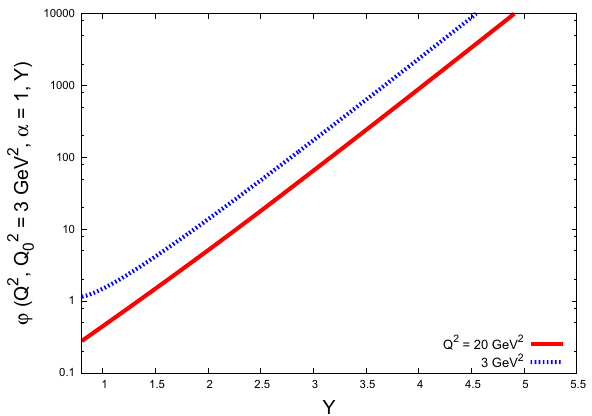
vector components with n = 3 , 20, and α = 1 (cid:4) φ vector in the truncated BFKL case, in the present work the expression in Eq. (23) for a matrix of size N = 50 with an = δ N 0 ) and a coupling initial condition N 0 = 3 (with ϕ 0 i i α = 1 has been calculated. Then, a look at the n = 3 , 20 components of the resulting (cid:4) φ and the study of its dependence with Y is provided in Fig. 6. It can be seen that the behaviour is very similar to that of the BFKL gluon Green’s function in Fig. 5 but with a smaller growth in the truncated case (note that in BFKL the asymptotic growth corresponds to the Pomeron intercept 4 log ( 2 ) ). It is possible to investigate how the asymptotic growth in the square truncation changes with the matrix size. Let us (cid:4) ψ ( N ) the N eigenvectors of the N × N matrix denote by L